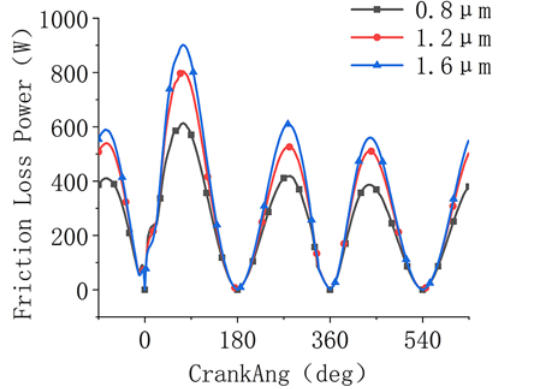
Fig. 21. Cylinder liner roughness friction loss relationship